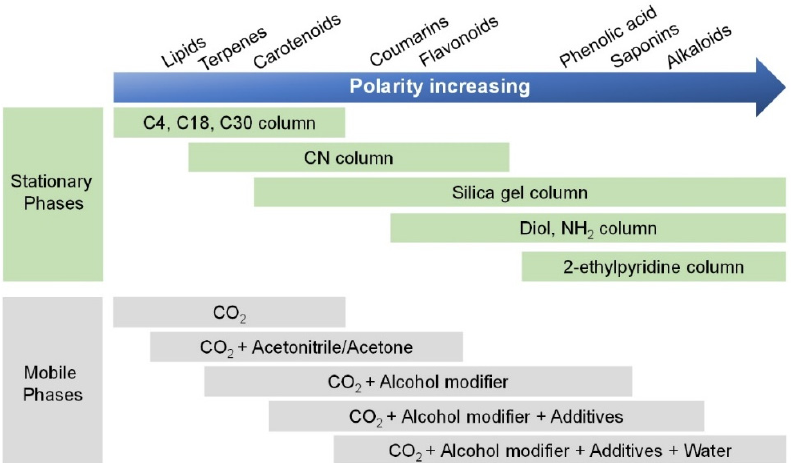
Figure 3. Overview of the specific stationary phases and mobile phases that match the solute. As the polarity of the solute increases, so does the polarity of the stationary phase and mobile phase.